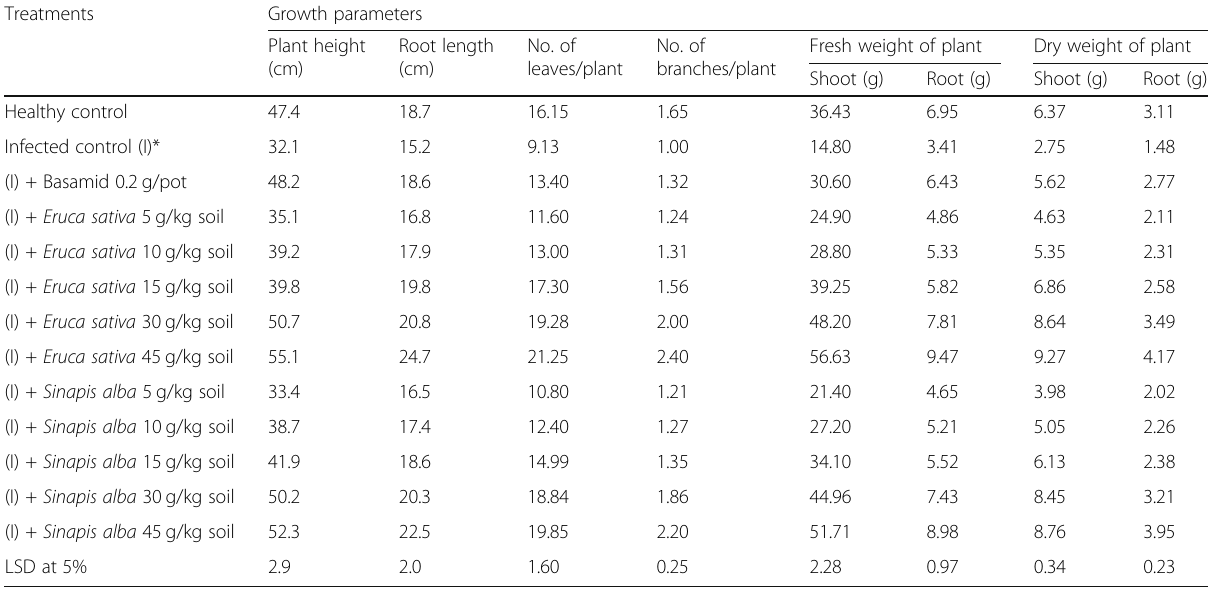
Table 2 Effect of different concentrations of both Eruca sativa L. and Sinapis alba L. seed powder and herbicide Basamid on growth parameters of Lycopersicon esculentum Mill. at 45 days from transplanting. (average of the two seasons) Treatments